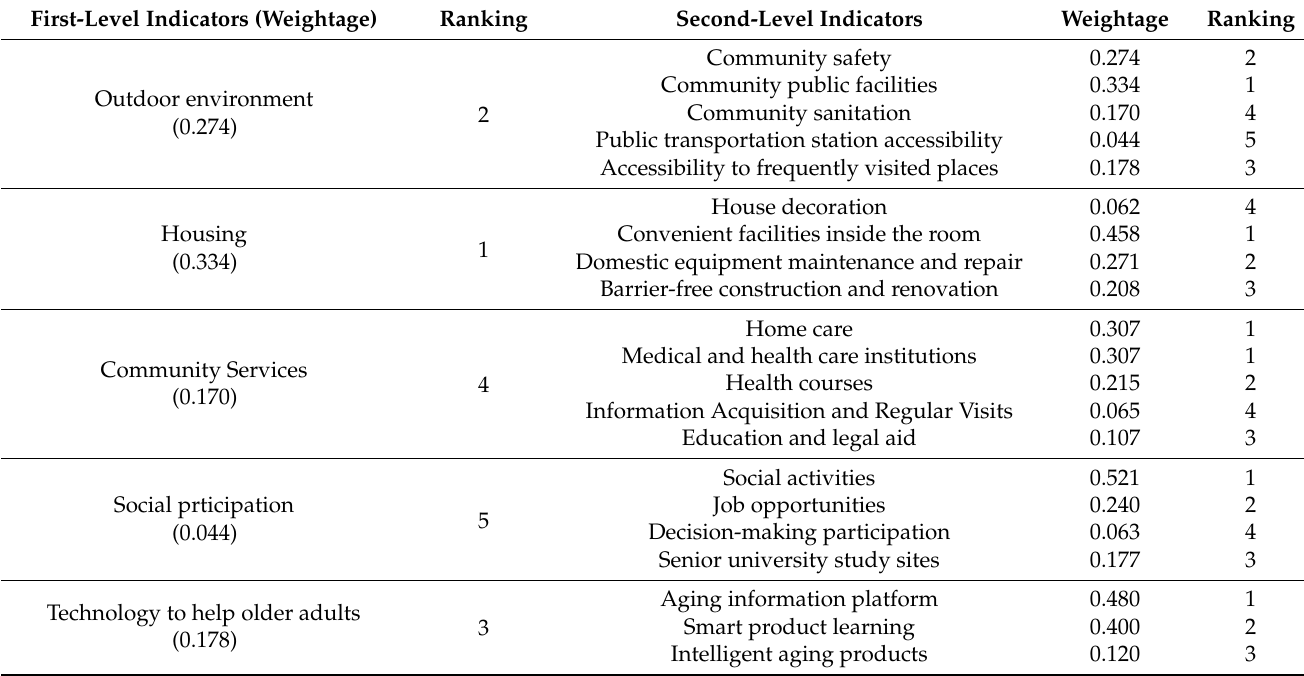
Table 6. Weighting and ranks for the indicators tested with